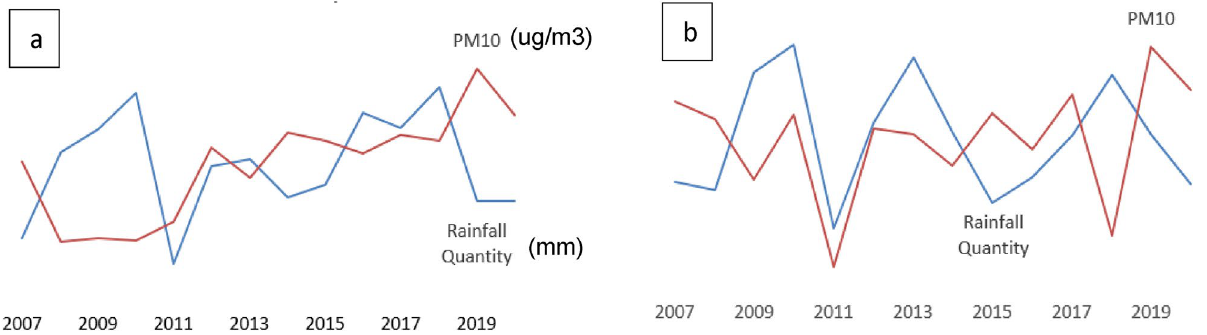
Figure 2. Temporal dynamic of changes in PM10 and rainfall. ( a ) Full year and ( b ) rainy